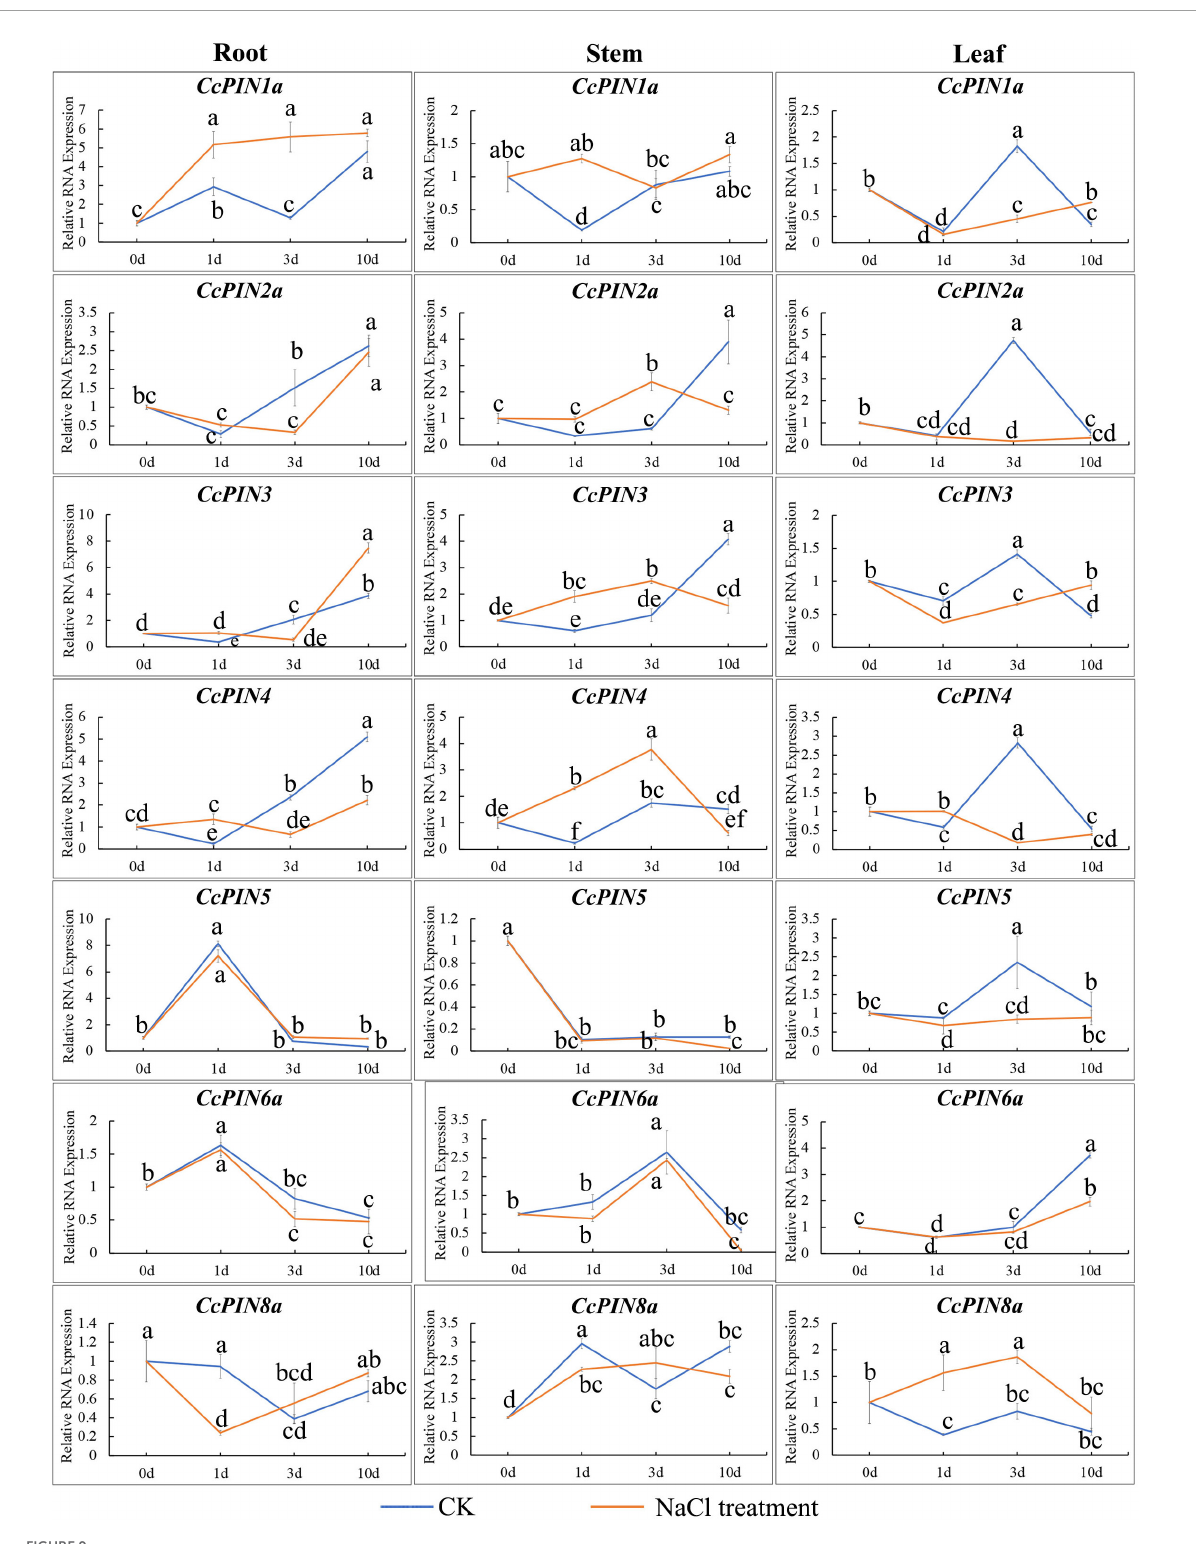
FIGURE9 Relative RNA expression of CcPIN genes under CK (H 2 O) and salt stress treatments. 0, 1, 3, and 10 d represent 0, 1, 3, and 10 days after treatment, respectively. The sample from the CK group collected 0 days after treatment was regarded as the control sample. Different letters near the points indicate a significant difference in different treatments ( P <